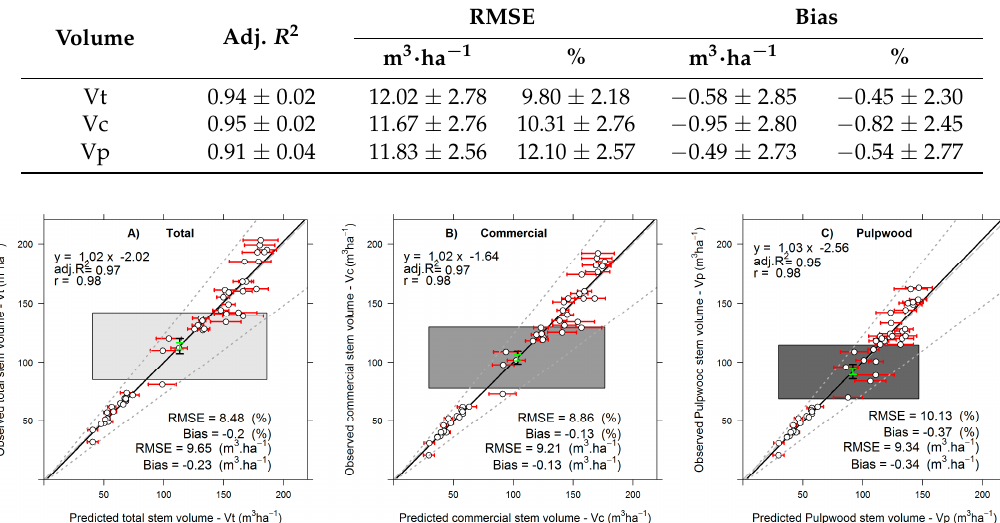
Table 8. Model accuracies per stem volume type. The average and standard deviation of Adj. R 2 , RMSE and bias derived from the 500 bootstrap runs are displayed.